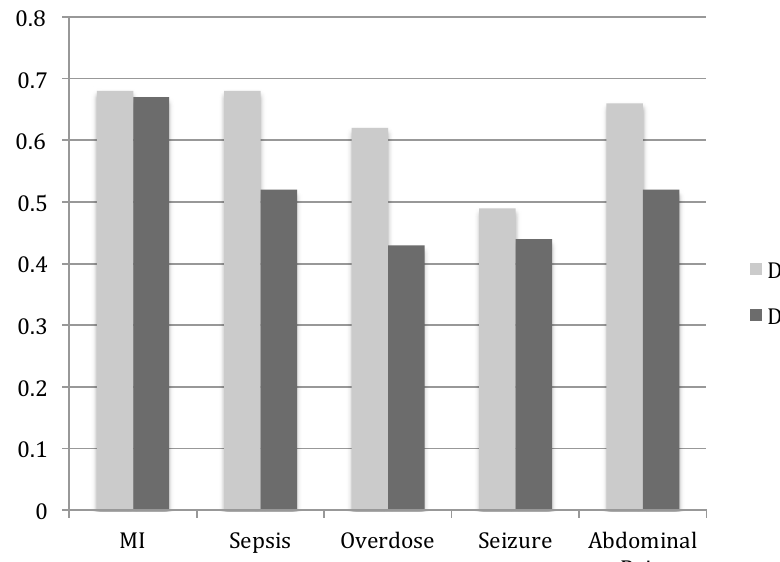
Figure 3: Difficulty and discrimination indices of individual OSCE